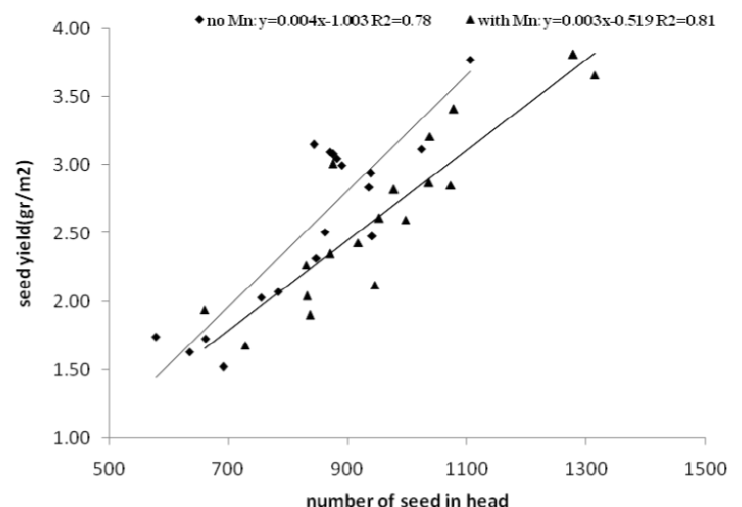
sunflowerFig. 2. Relationship between seed yield and number of seed per head in case of Mn (with Mn) and without Mn (no Mn) application in sunflower